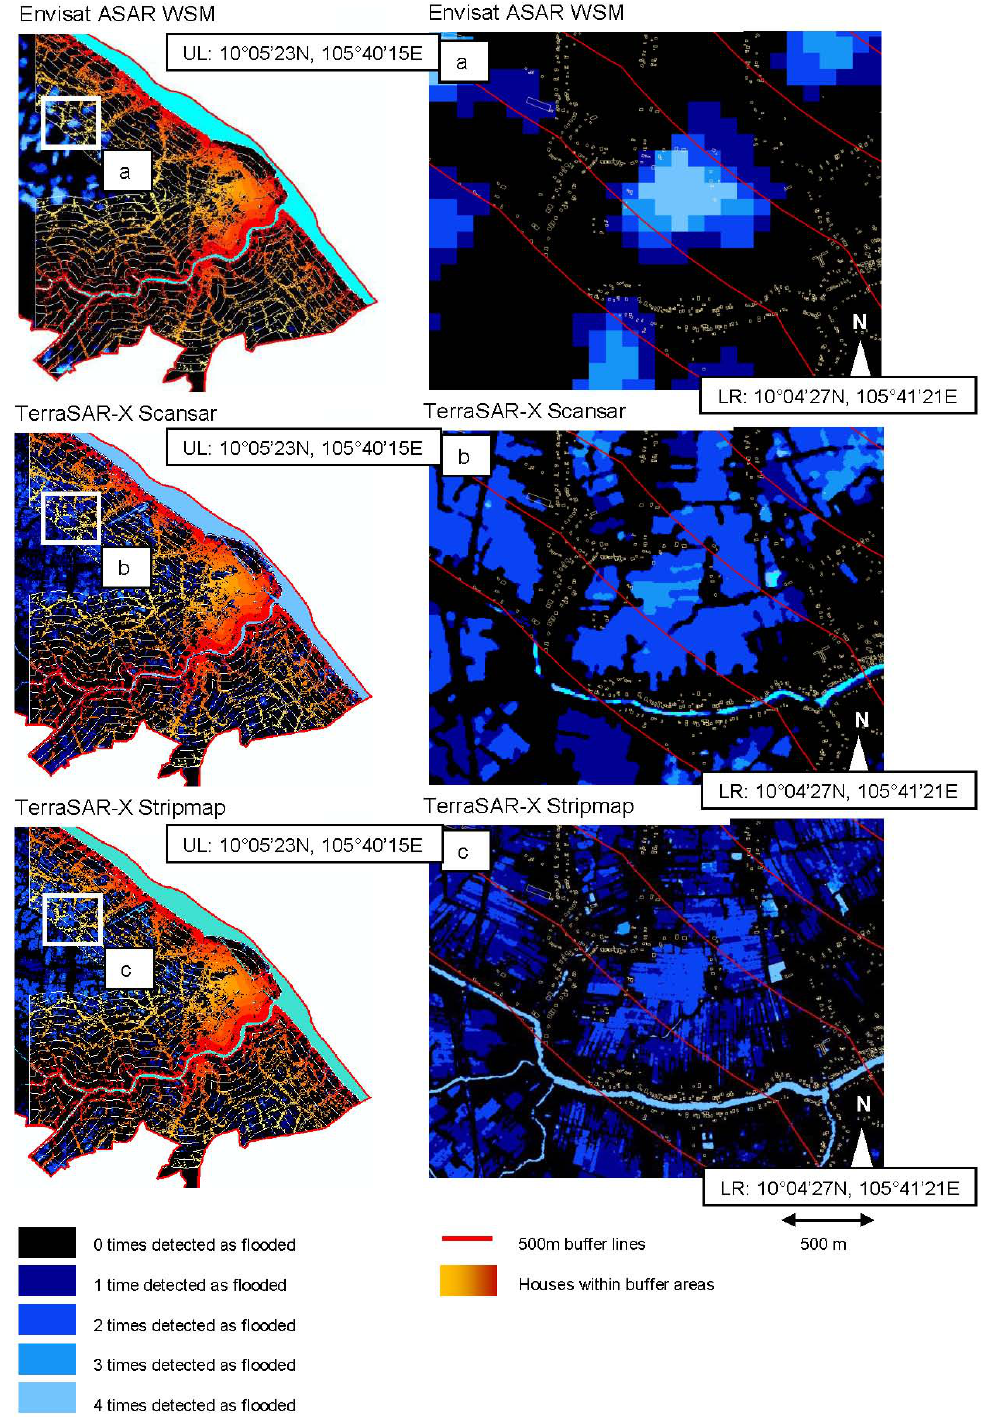
Figure 9. Capability of Envisat ASAR-WSM ( a ), TerraSAR-X Scansar ( b ), and TerraSAR-X Stripmap ( c ) for urban flood